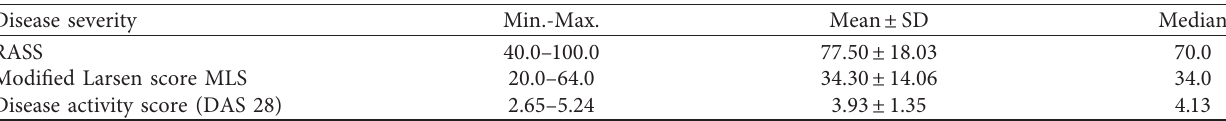
Table 2: Clinical and radiological parameters of disease activity and clinical and radiological parameters of disease severity in patients with established RA.